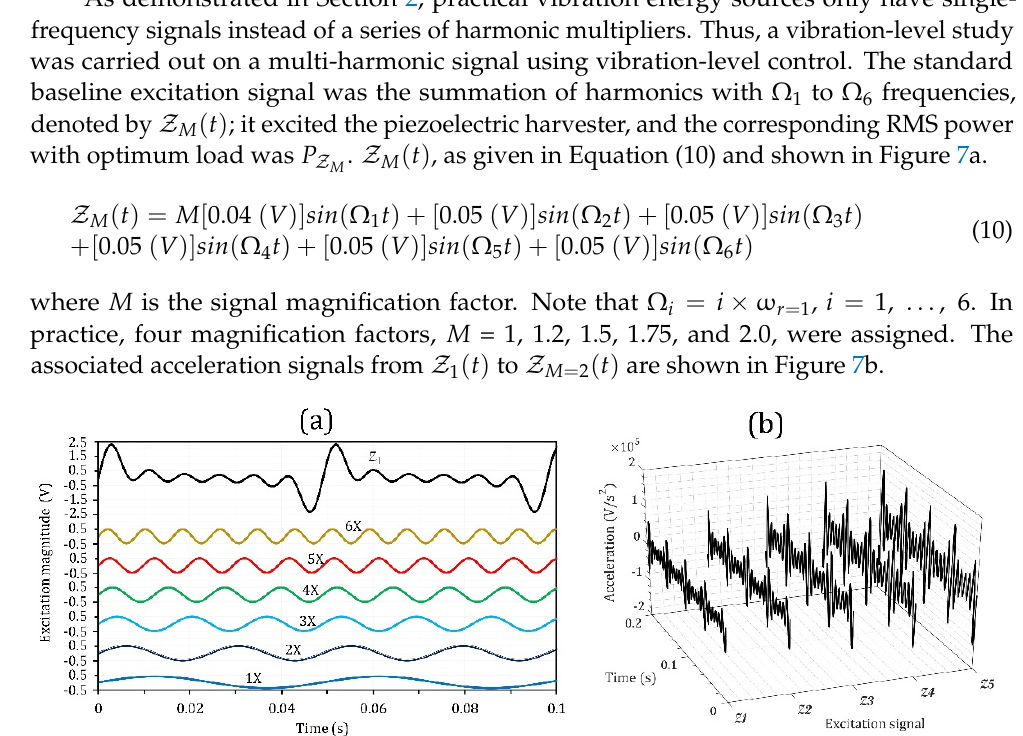
Figure 8. ( a ) Output power for different vibration-level multi-frequency excitation signals and ( b ) normalised power versus magnification factor.